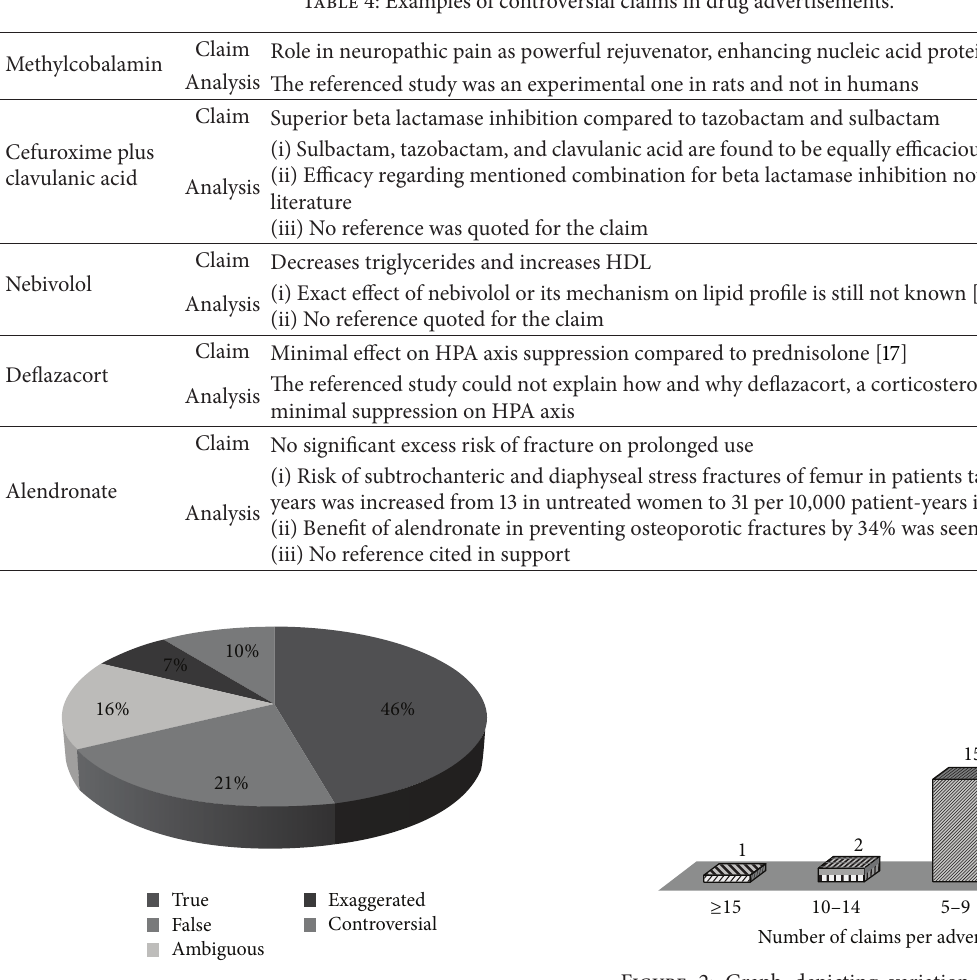
Table 4: Examples of controversial claims in drug advertisements.